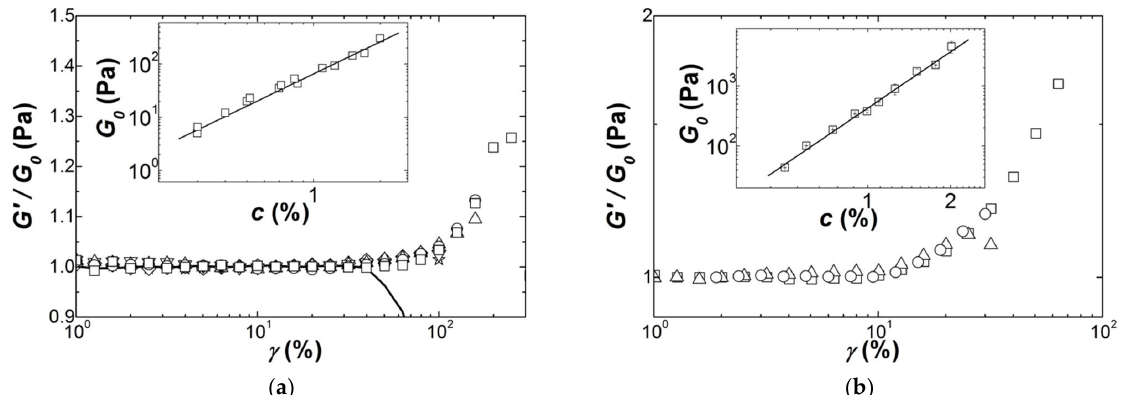
Figure 7. Strain dependence of the shear storage modulus G′ scaled by the linear shear modulus G 0 of the corresponding gels: ( a ) Iota gels with 0.3 wt.% (squares), 0.5 wt.% (circles), 0.7 wt.% (up triangles), 0.8 wt.% (down triangles), 1.1 wt.% (diamonds), 1.25 wt.% (stars) and 2 wt.% (line); ( b ) Kappa2 gels with 0.5 wt.% (squares), 0.75 wt.% (circles) and 1.1 wt.% (triangles). Insets present the concentration dependence of G 0 and lines are power law fits to the data.